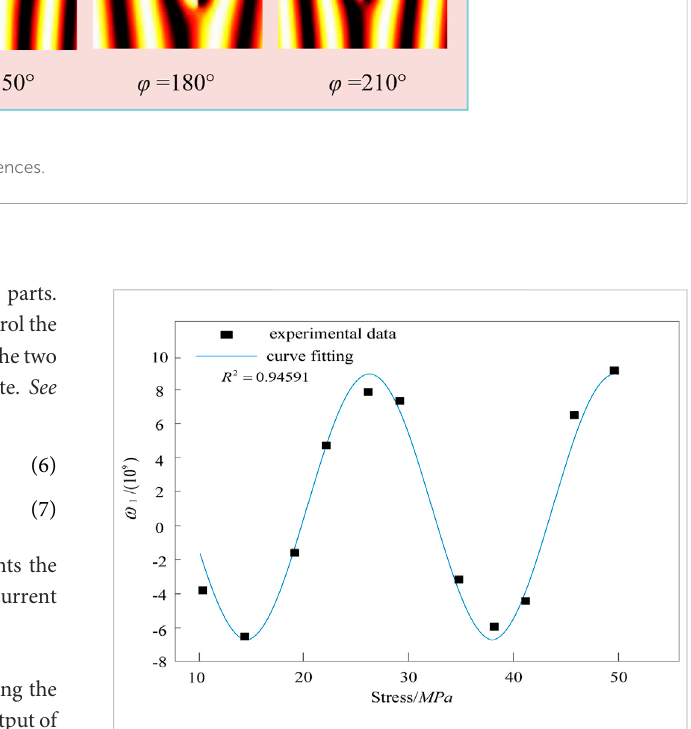
FIGURE 5 Relationship between characteristic correlation coef fi cient ω 1 and